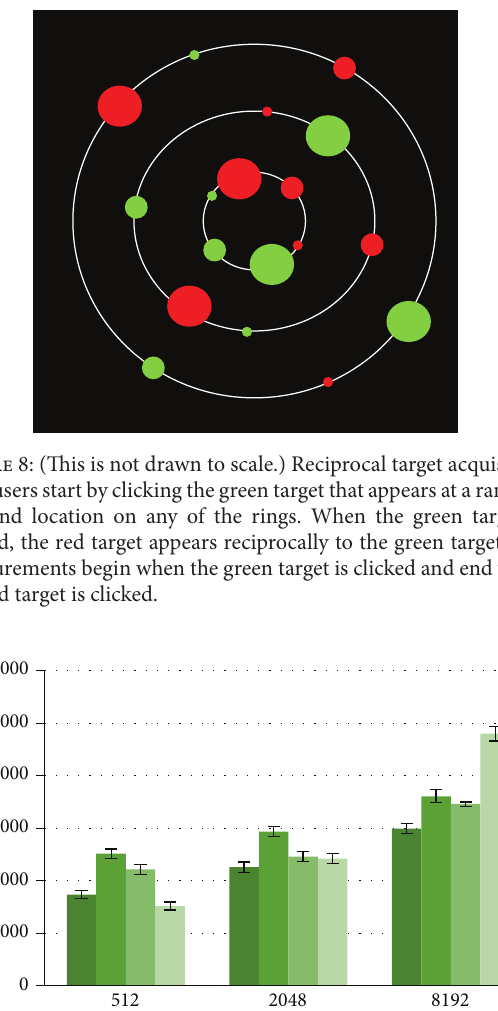
Figure 9. Analysis of variance with repeated measures